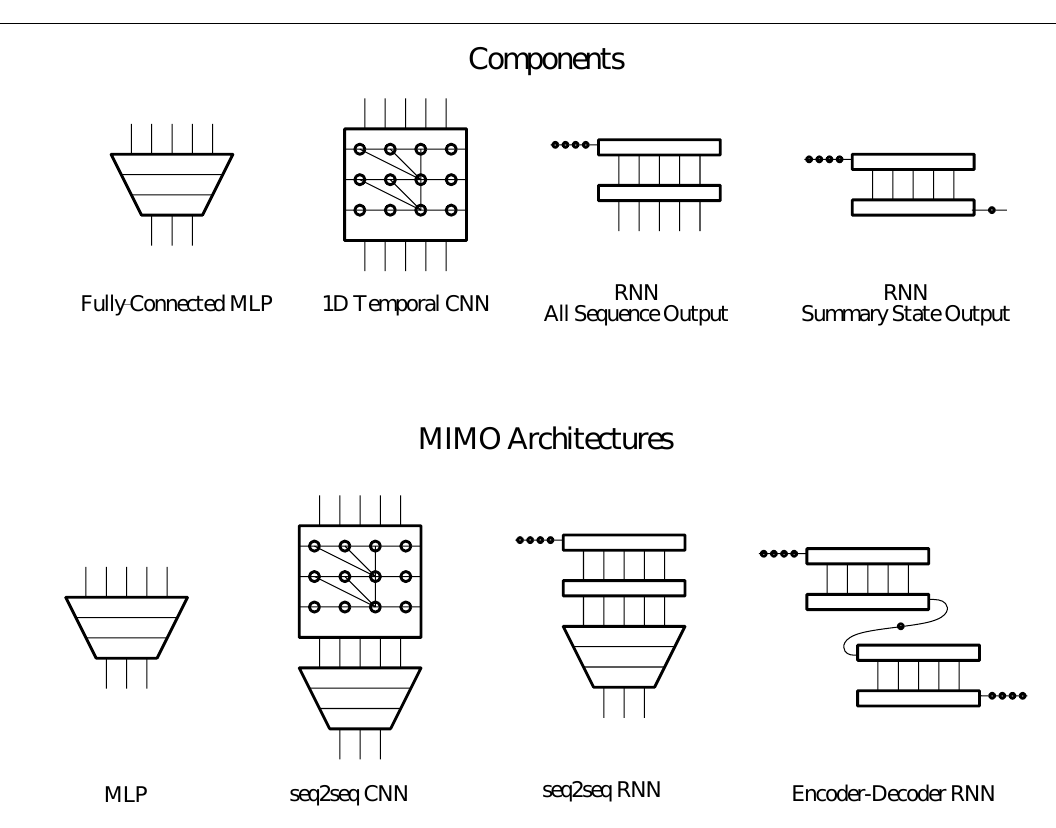
Figure 1. Multiple Input Multiple Output (MIMO or seq2seq) deep learning architectures’ testing. MLP: Multi-Layer Perceptron seq2seq (see Section 3.2.1); CNN: Convolutional Network seq2seq